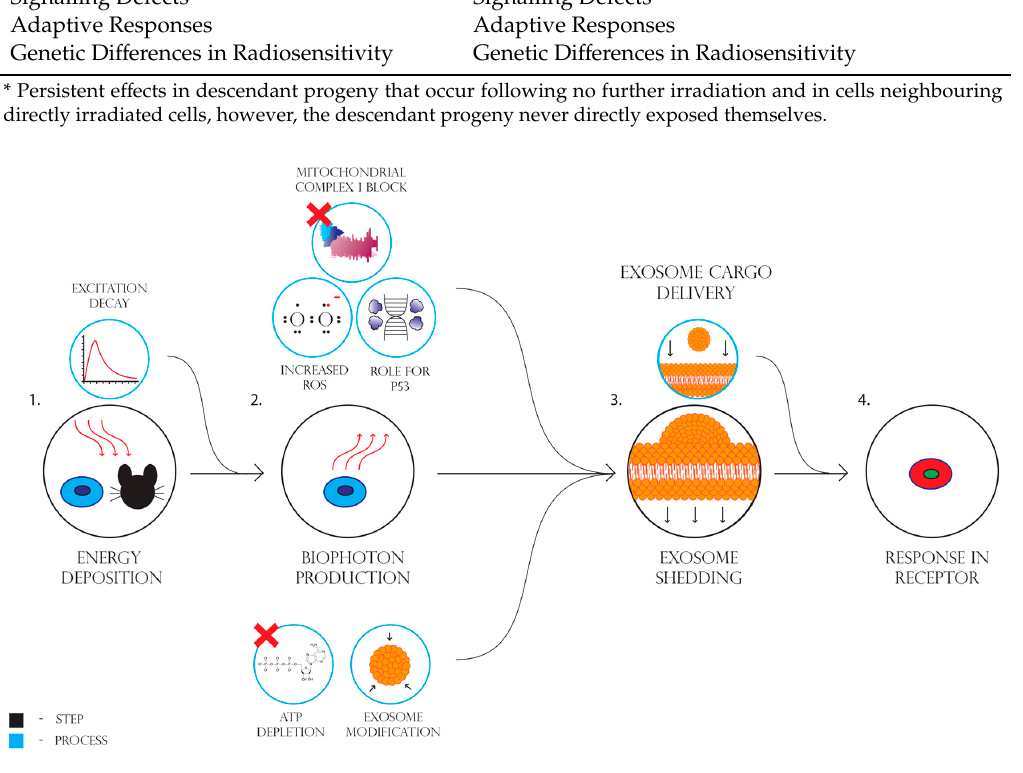
Figure 7. Steps and processes involved in the bystander effect as currently understood.